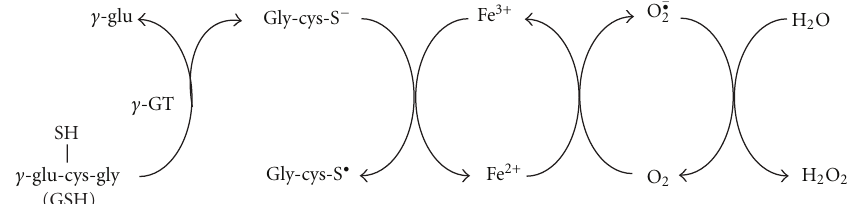
Scheme 1: γ -Glutamyl